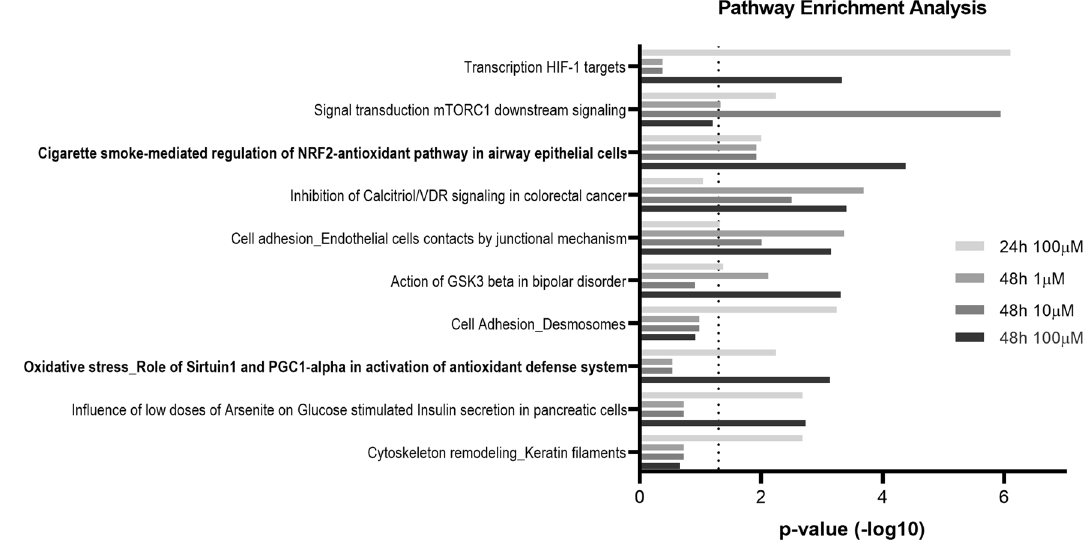
Figure 2. Pathway enrichment analysis of significantly differential proteins. Pathway enrichment analysis with MetaCore software performed on significantly differential proteins (|FC|> 1.2, LFDR < 0.05, n = 3 replicates) in HBMECs treated with morphine for 24 h and 48 h. The top 10 pathways are represented. The X axis consists in p-values, which are represented in − log10 ( p -value). The dashed line corresponds to the p-value cut-off set at 0.05. Bold pathways are associated to the Nrf2